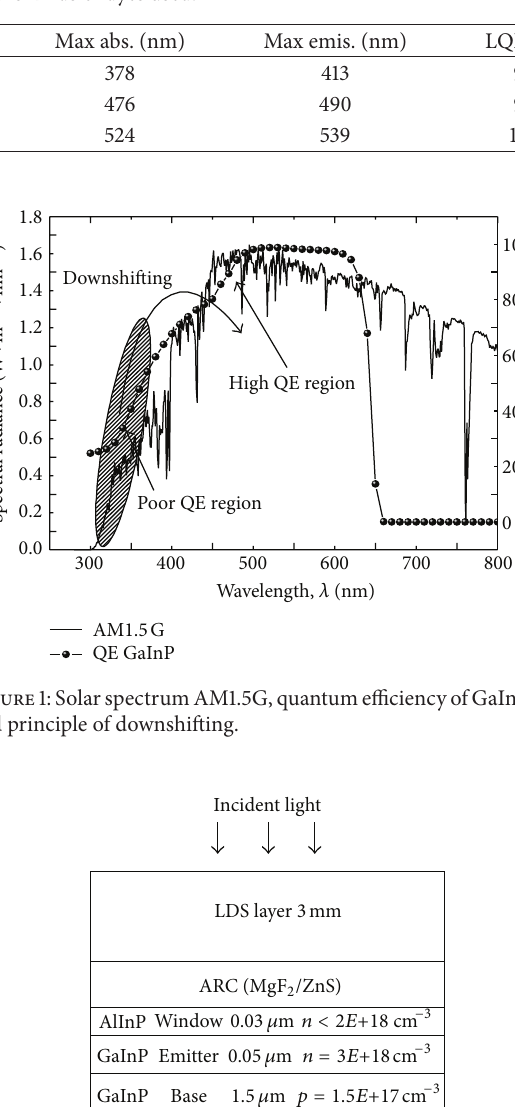
Table 1: Optical properties of diver’s kinds of dyes used.